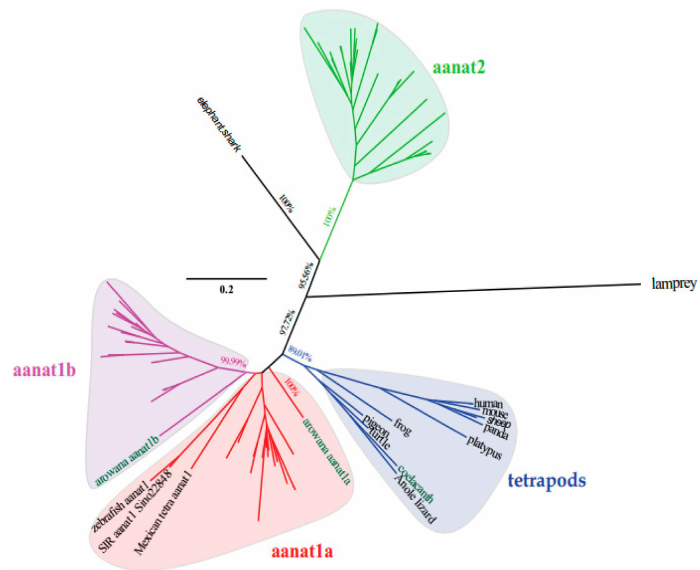
Figure 2. The radial Bayesian phylogenetic tree based on the conserved blocks of all aanat CDS sequences. The analysis was performed using the MrBayse 3.2 software. Evolutionary model selection was calculated using the MrMTgui program (the best nucleotide substitution model was GTR + I + G). The phylogenetic tree is rooted with lamprey ( Petromyzon marinus ) aanat . Although the PhyML and Mega phylogenetic trees are not shown here, they present the same tree topology. Four aanat subgroups are shown with different colors (Blue, tetrapod aanat ; Red, teleost aanat1a ; Magenta, teleost aanat1b ; Lime, teleost aanat2